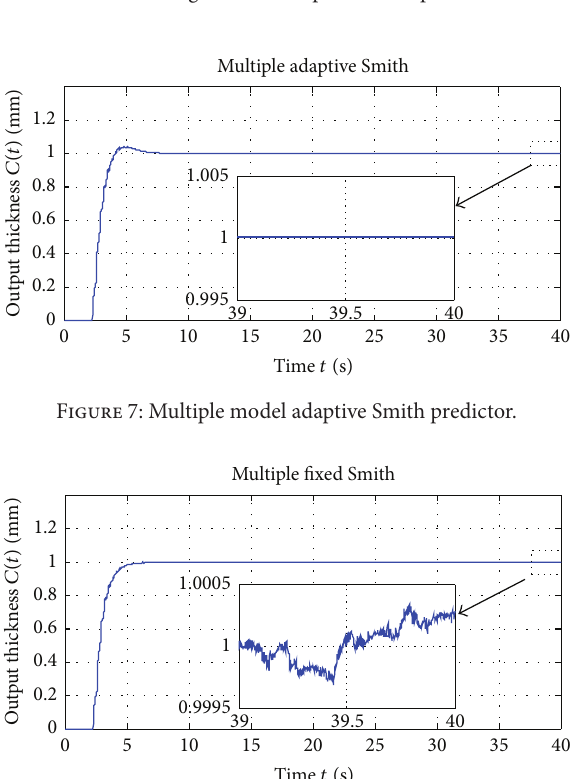
Figure 6: Single model adaptive Smith predictor.